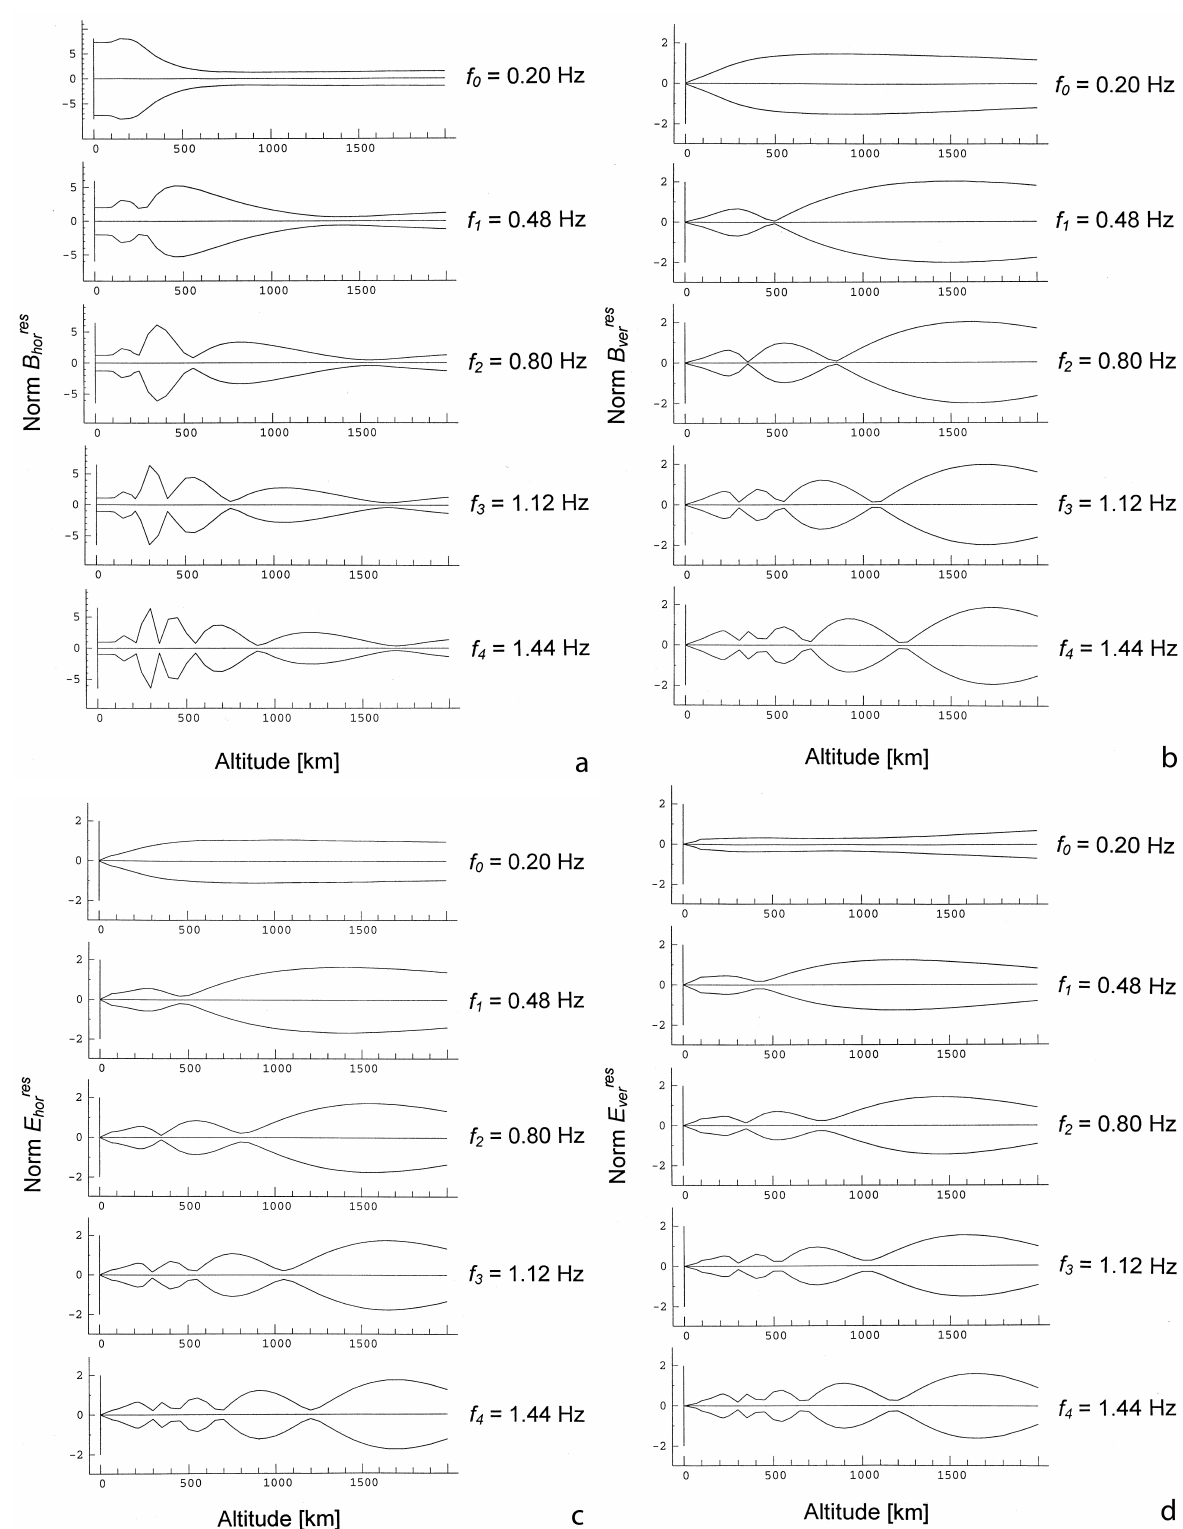
Fig. 5. The normalized altitude profiles of amplitudes of the magnetic field horizontal component B hor (a) , the vertical component B ver (b) , the electric field horizontal component E hor (c) , and vertical component E ver (d) for frequencies f 0 and f 4